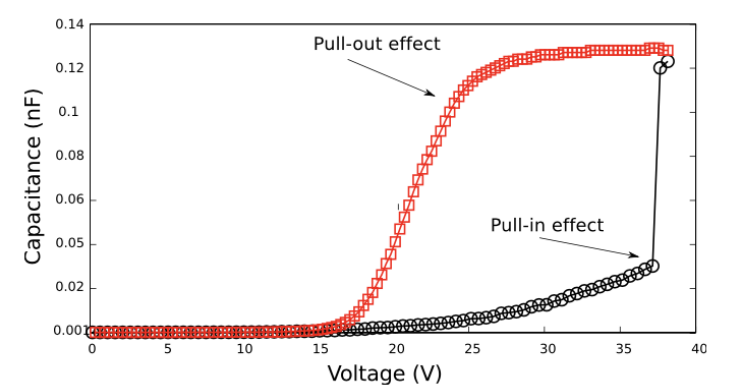
Figure 9. Hysteresis cycle obtained for the characterisation of the functionalised suspended beam. The pull-in effect was obtained as the numerical analysis shows. In contrast, the pull-out effect occurred in a smooth way due to the length of the beam and because of the short-range